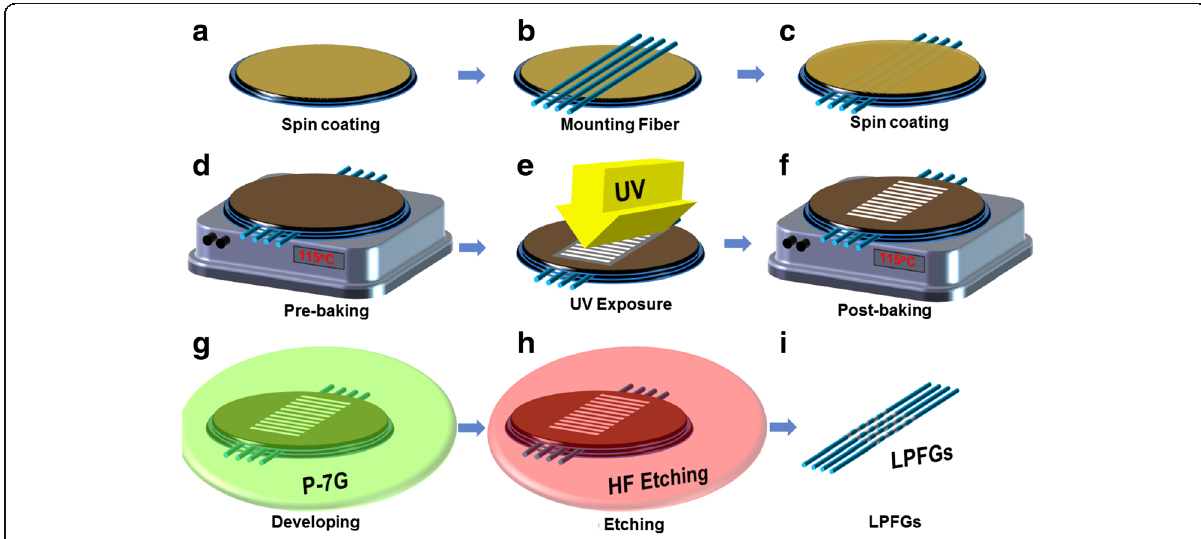
Fig. 1 Fabrication procedure of the PCF-based LPG by using a wet etching technique. a spin coating, b mounting fiber, c spin coating, d pre-baking, e UV exposure, f post baking, g developing, h etching, and i fabrication of